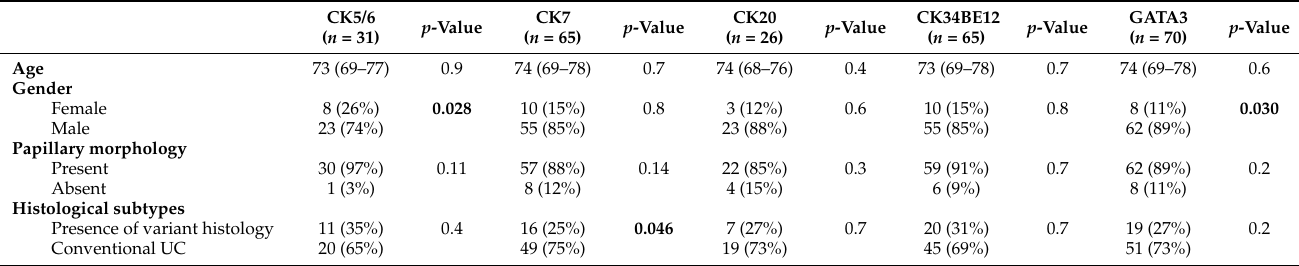
Table 2. CK5/6, CK7, CK20, CK34 β E12, and GATA3 expression in MIBCs regarding different clinicopathological features. p -value < 0.05 are highlighted in